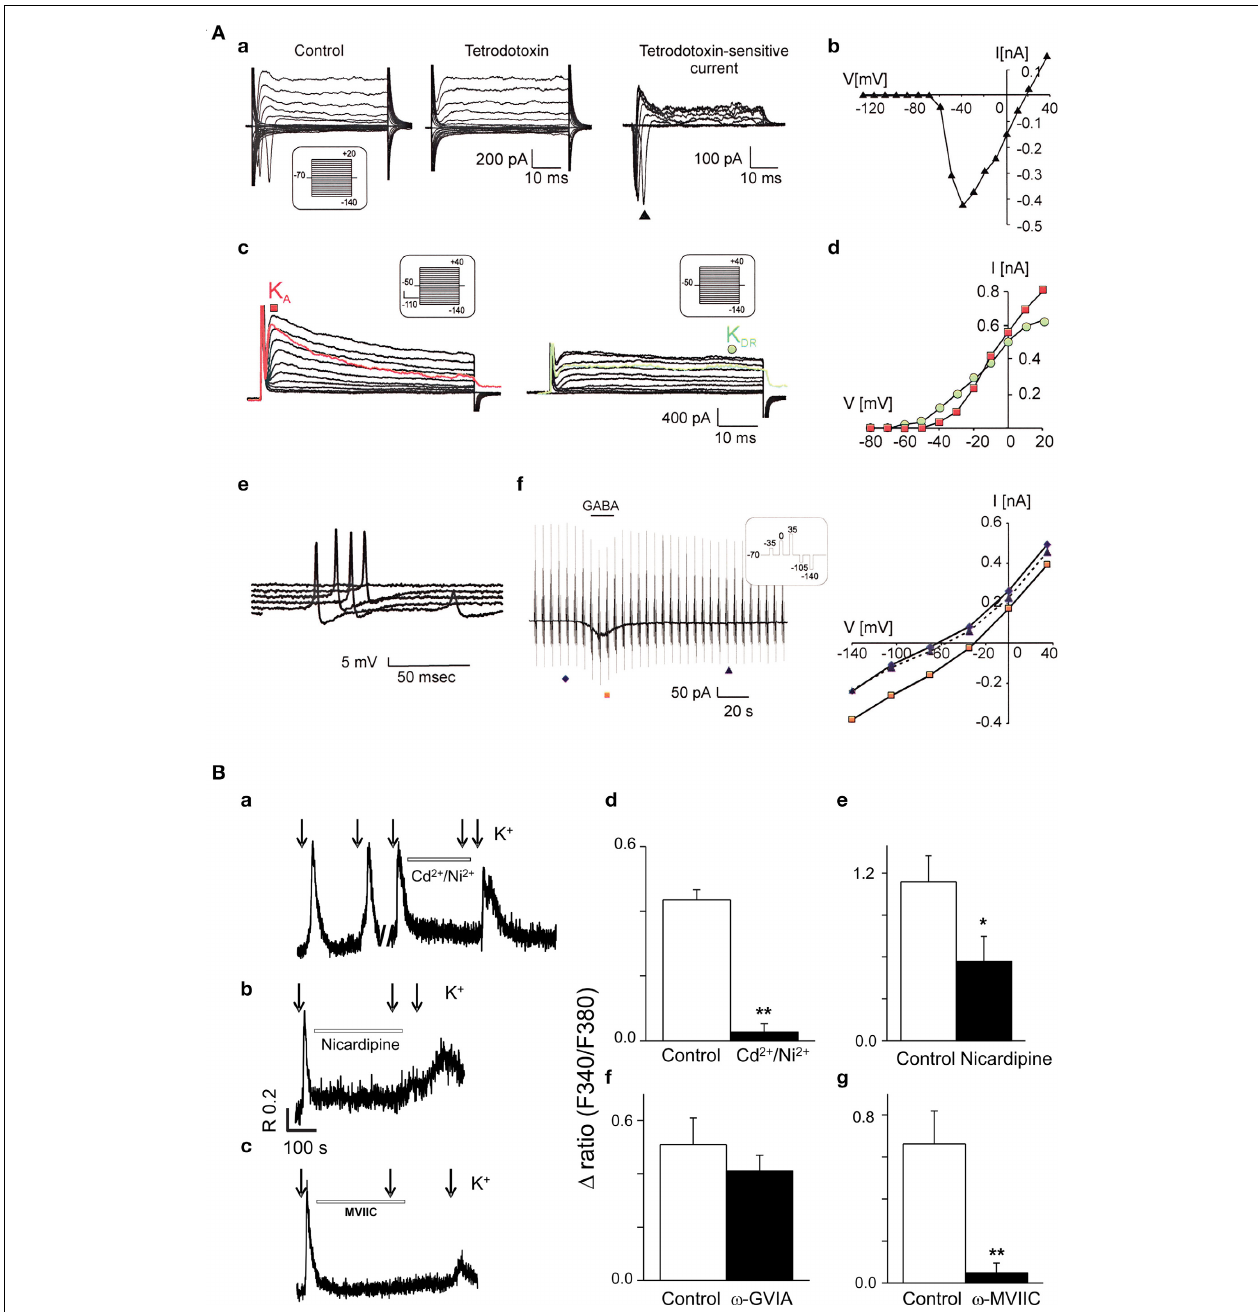
FIGURE 2 | Functional characterization of neurones derived from human stem cells. (A) CCTL14 hESC-derived neural precursors express a typical neuronal current pattern in vitro . (a) Typical membrane current pattern of a β -III tubulin-positive cell before and after the application of 1 μ M tetrodotoxin and the tetrodotoxin-sensitive current. (b) The corresponding I/V relationship. (c) Fast activating A-type K + current (K A , red color) and delayed outwardly rectifying K + current (K DR , green color). (d) Corresponding I/V relationships for K DR (filled circles) and K A (filled squares). (e) Action potential generation by β -III tubulin-positive cells demonstrated by representative voltage responses to an increasing current injection (in 10-pA steps). (f) GABA-evoked currents (left) and corresponding I/V relationships for control traces prior to (filled diamonds), during (filled squares), and after GABA washout (filled triangles, right). Reproduced from Kozubenko et al. (2010) with